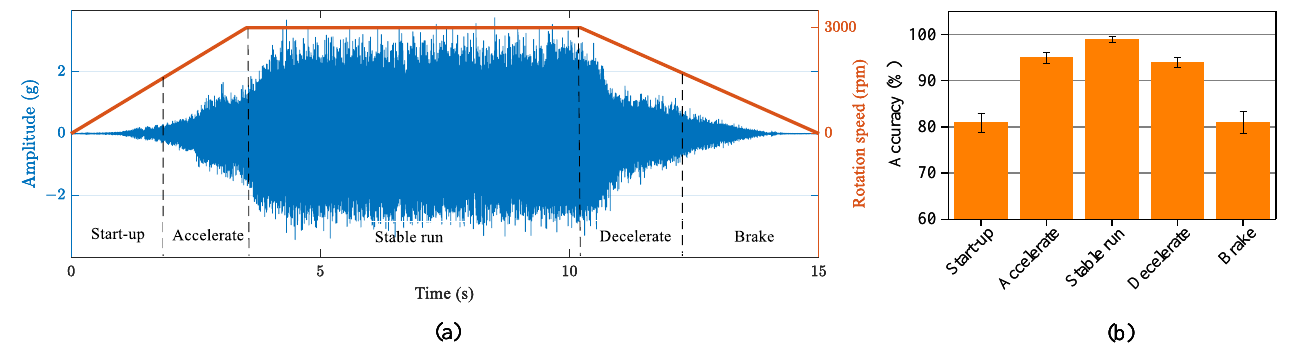
Figure 14. Fault diagnosis based on SQV dataset by speed interval: ( a ) division of speed period; ( b ) the diagnosis results of each time